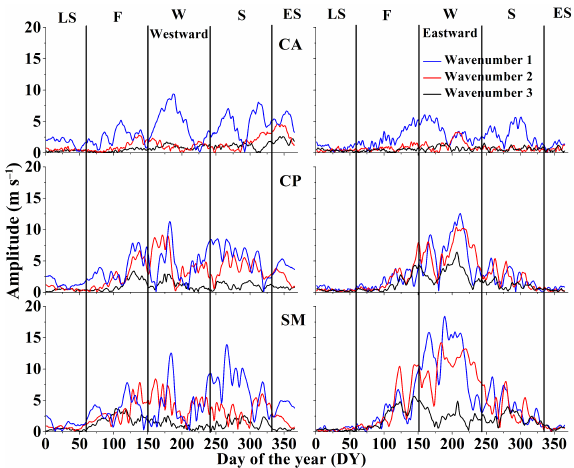
Figure 6. Amplitude of the eastward and westward propagating 16- day wave at 10hPa pressure level at three stations corresponding to the zonal wave numbers 1, 2, and 3 derived from the ECMWF zonal wind.